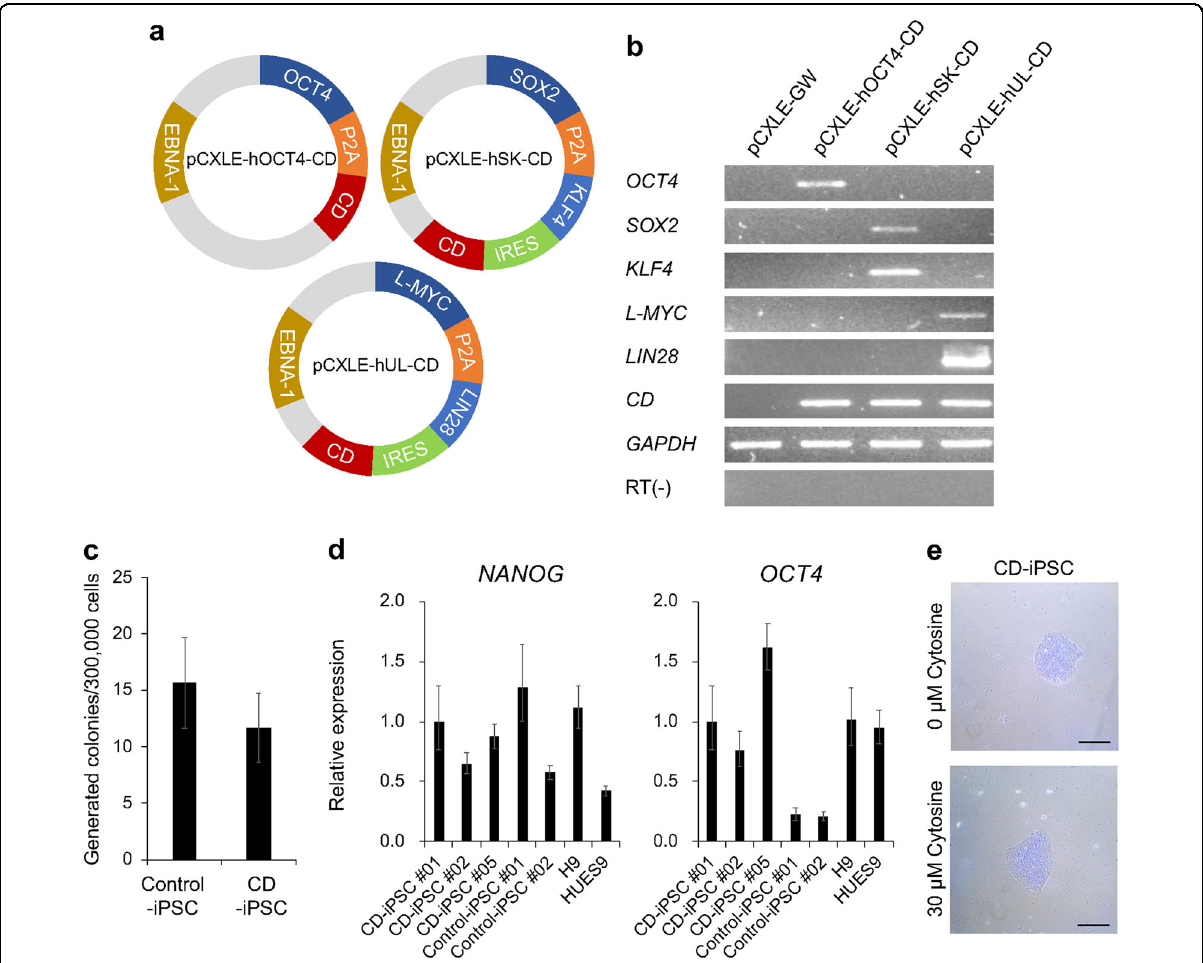
Fig. 2 iPSC reprogramming with CD episomal vectors. a Schematics of the three CD episomal vectors are shown. b RT-PCR was conducted to con fi rm the expression of exogenes in each CD vector in 293T cells. The pCXLE-GW plasmid is an empty vector that was used as a negative control. c The number of generated colonies was counted. This experiment was performed in triplicate. d Quantitative PCR was conducted to evaluate the expression levels of OCT4 and NANOG in CD-iPSCs, control-iPSCs, and ESCs (H9 and HUES9). e Representative images of CD-iPSCs treated with or without